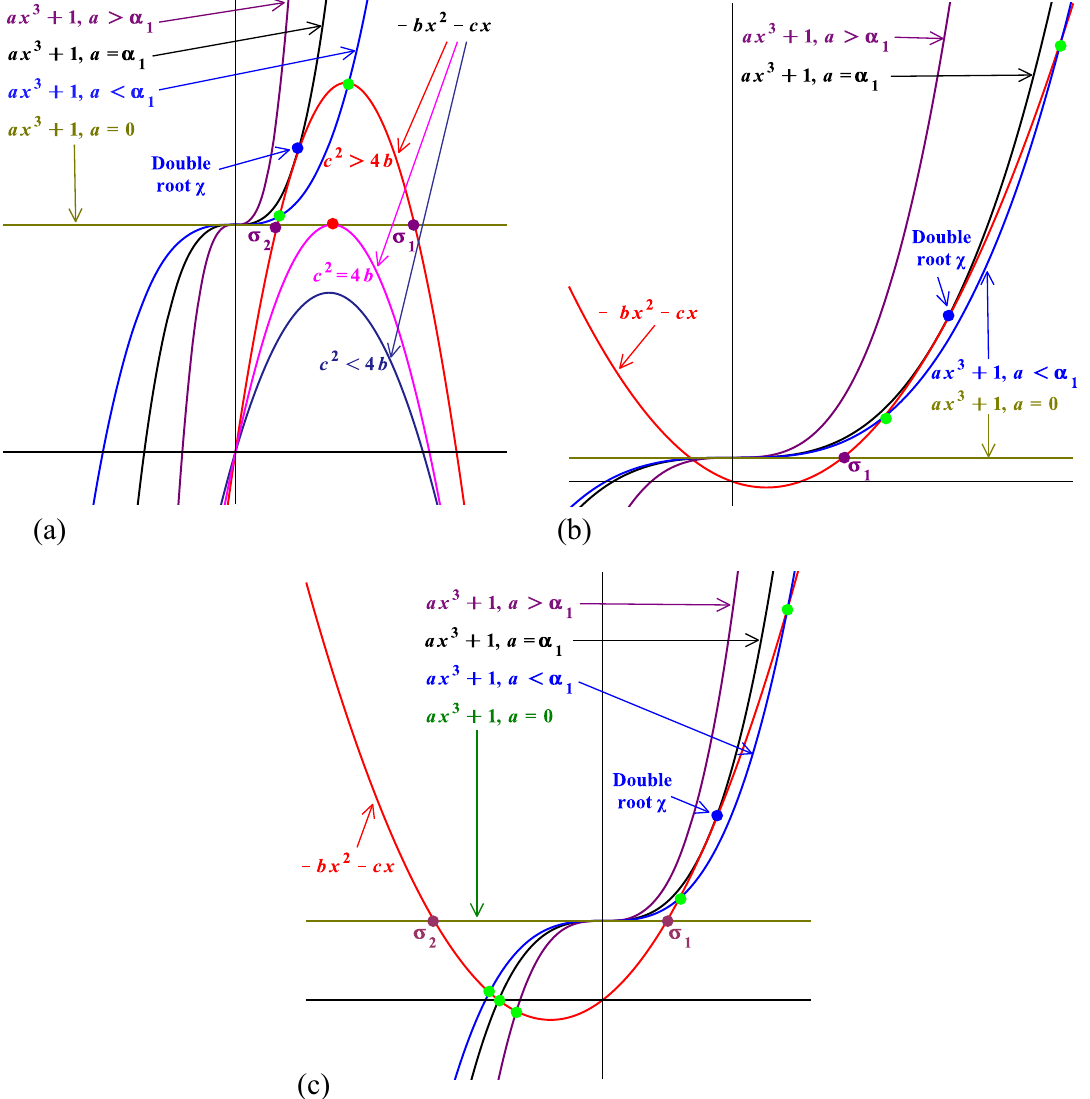
Figure 4: The cubic equation ax bx cx 1 − − 3 2 + = : the cases of